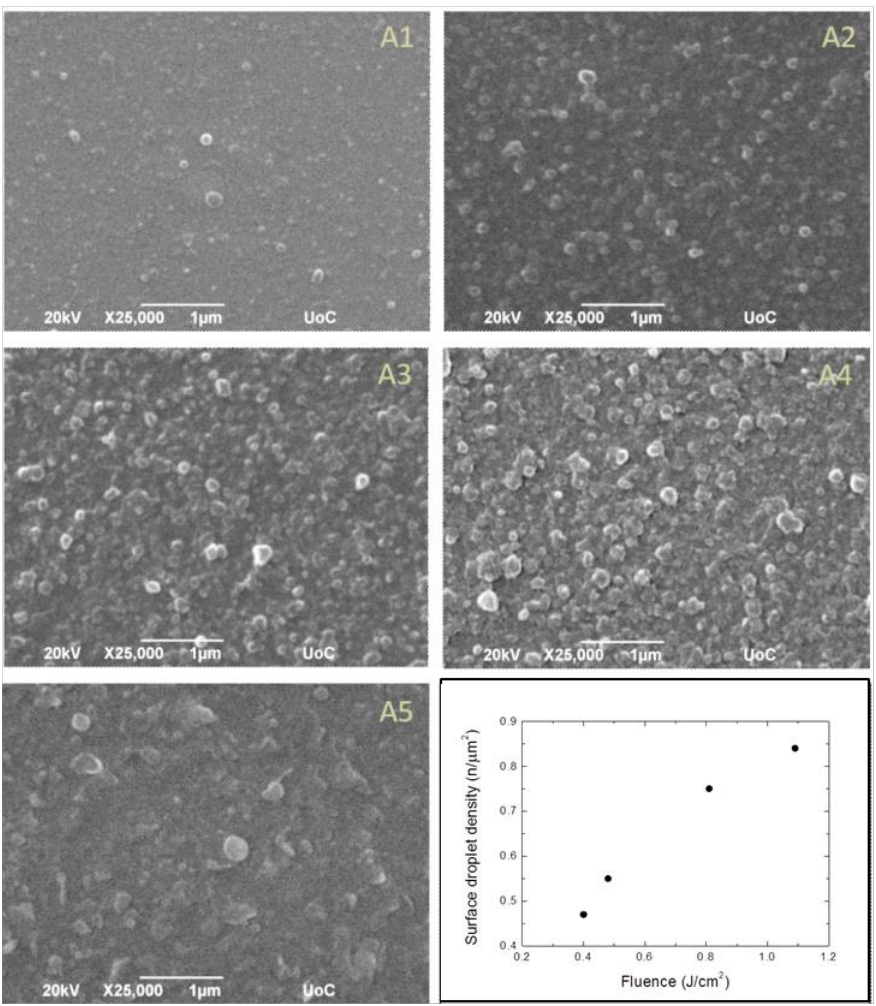
Figure 3. SEM micrographs of the deposited boron film substrates (A1 – A5) and a plot of surface droplet density as a function of the laser fluence obtained from samples in A1 – A4. The films present good surface flatness without